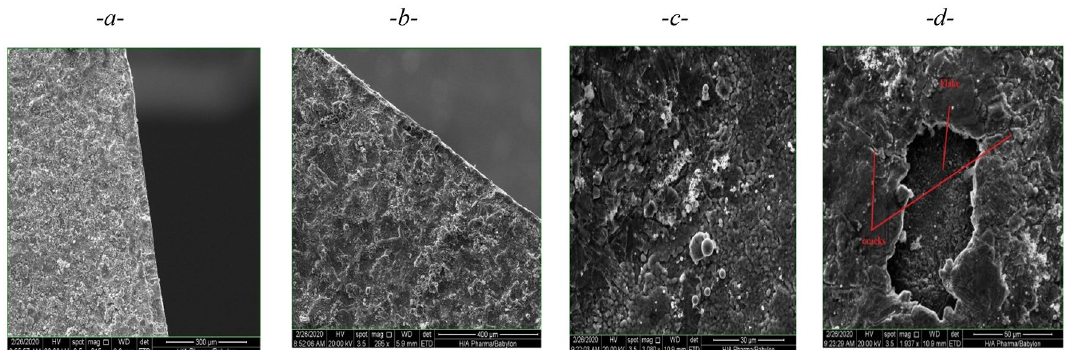
Figure 17. ( a ) 30 µm, ( b ) 40 µm, ( c ) 50 µm, ( d ) thickness more than 50 μm (Cracking, Flacking, and failure of coating for coating time more than 30